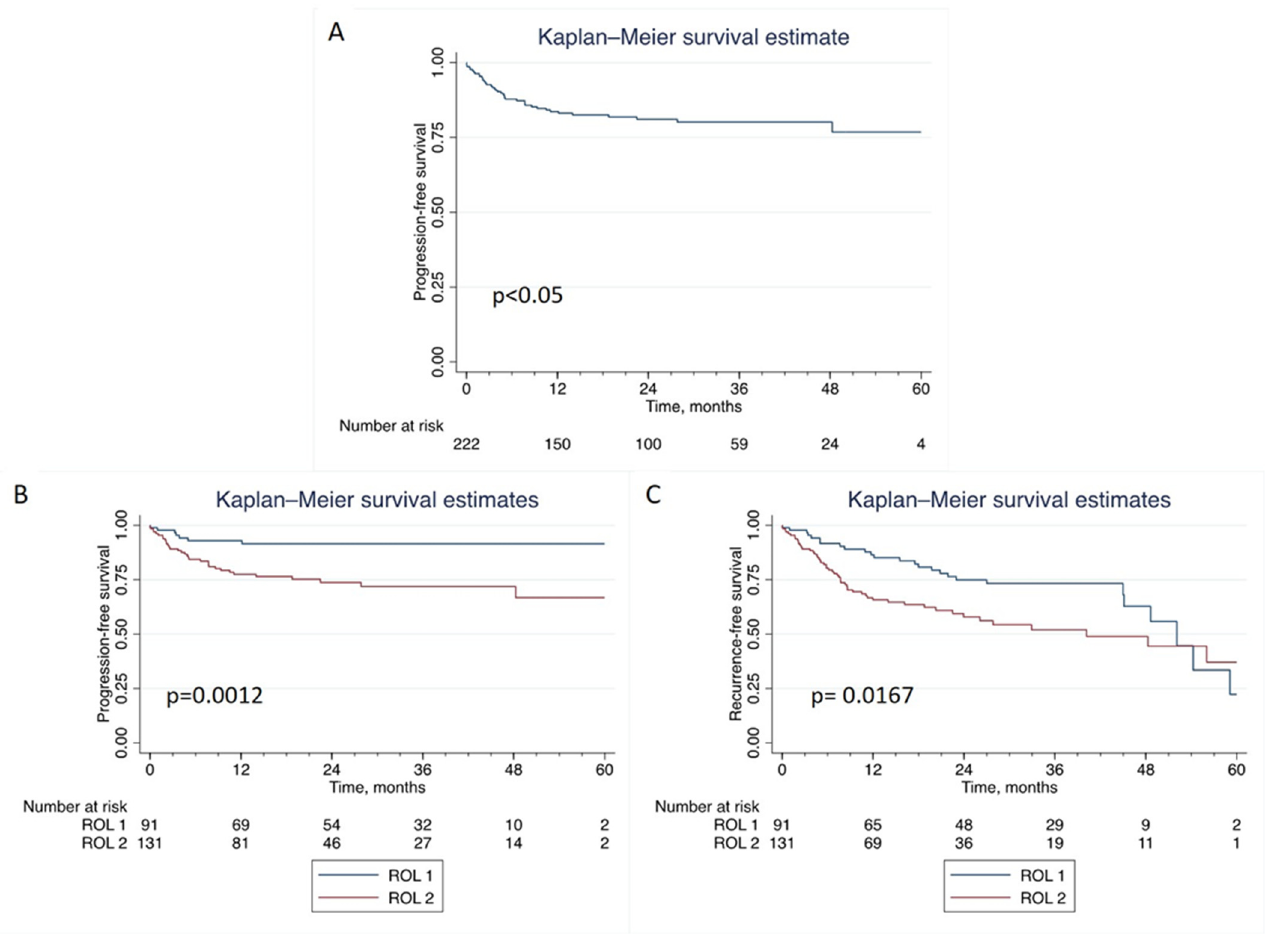
Figure 3. Kaplan-Meier (K-M) analyses for progression-free survival. ( A ) K-M estimates for progression-free ( B ) and recurrence-free ( C ) survival rates according to the ROL substaging system. ROL: Rete Oncologica Lombarda.